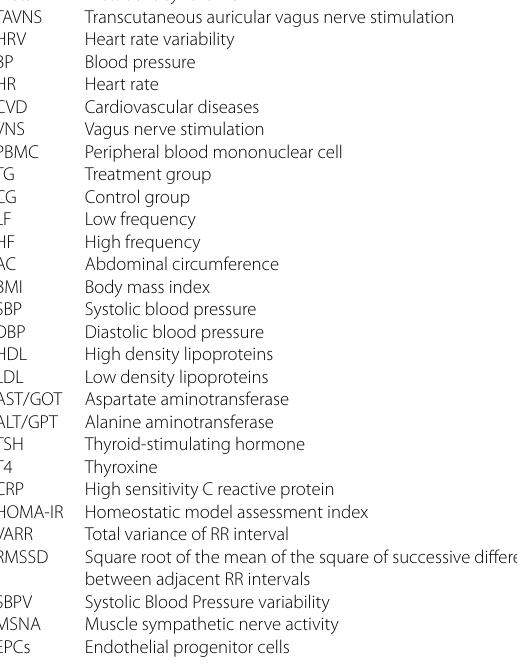
tary Table 2. Comparison of monocytes and endothelial cells of control and TAVNS groups at baseline and after 8-weeks of